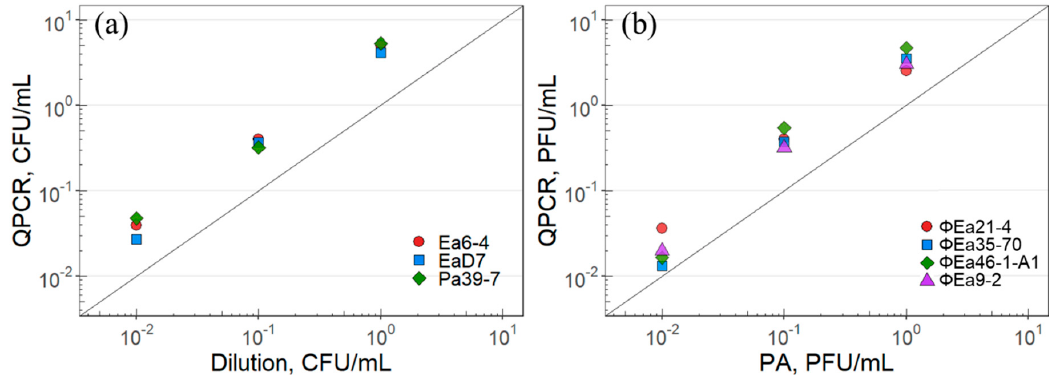
Figure 3. Correlation between the quantification using plating techniques and qPCR-based assays. ( a ) Bacterial quantification using dilution plating compared to qPCR for E. amylovora (Ea) and P. agglomerans (Pa). ( b ) Phage quantification using plaque assays compared to DNase-based qPCR for the four phages tested. The symbols represent the mean of matched-pair data produced in triplicate, which was normalized to the initial CFU/mL or PFU/mL. The diagonal lines represent prefect agreement between the two techniques.